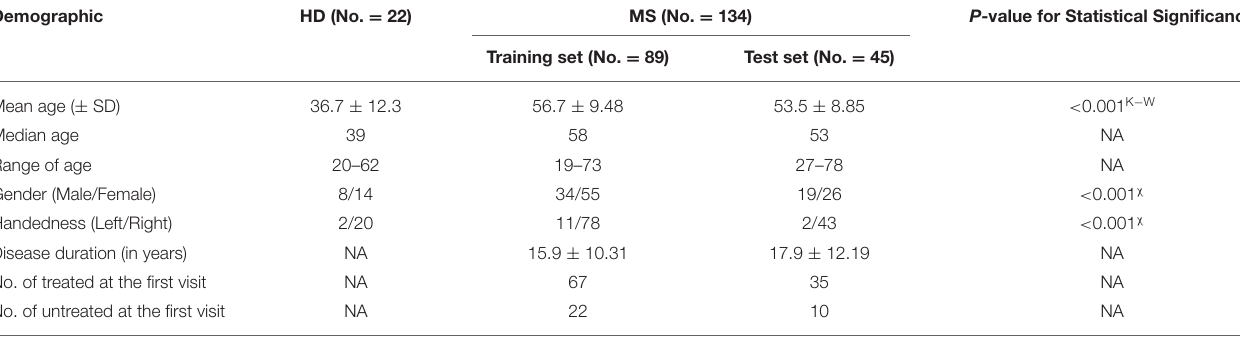
TABLE 1 | Demographics and characteristics for healthy donors (HD) and patients with multiple sclerosis (MS) over the 2 years of the study period.